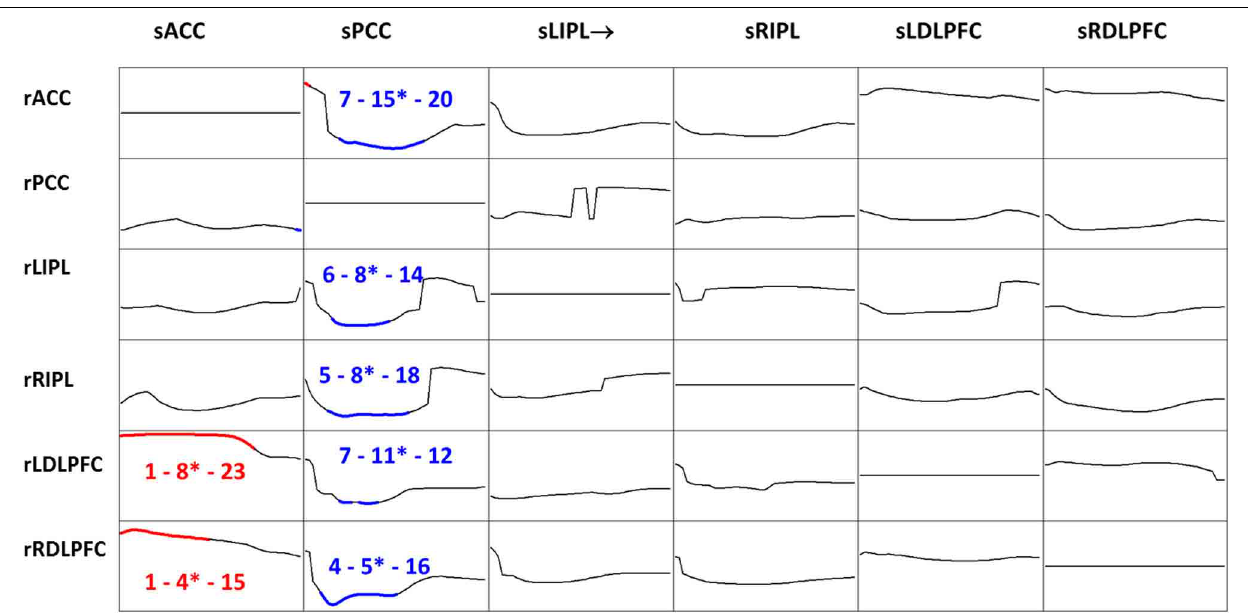
FIGURE 7 | t-Statistics comparing eyes open minus eyes closed iCoh for 109 subjects, in six regions of interest: anterior cingulate, posterior cingulate, left and right inferior parietal, and left and right dorsolateral pre-frontal cortices. Frequency axis: 1 to 30Hz. Corrected p = 0 . 05 was at t-threshold = 4.3, with vertical axis: − 7 to + 7. Blue